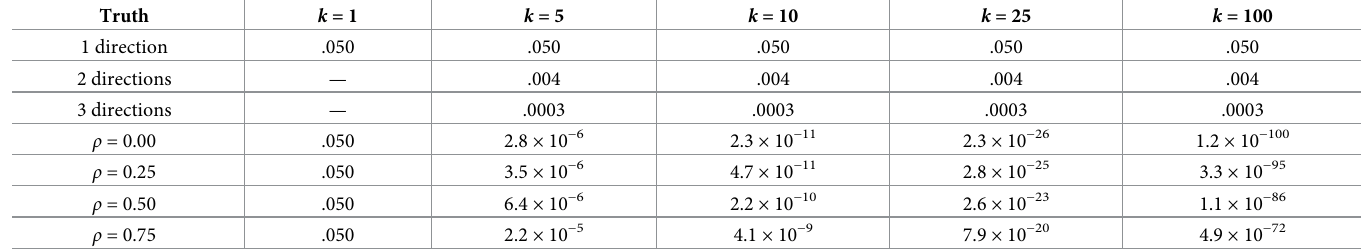
= 1 for all i , j (i.e., perfect correlation). The true S either has all variability ij